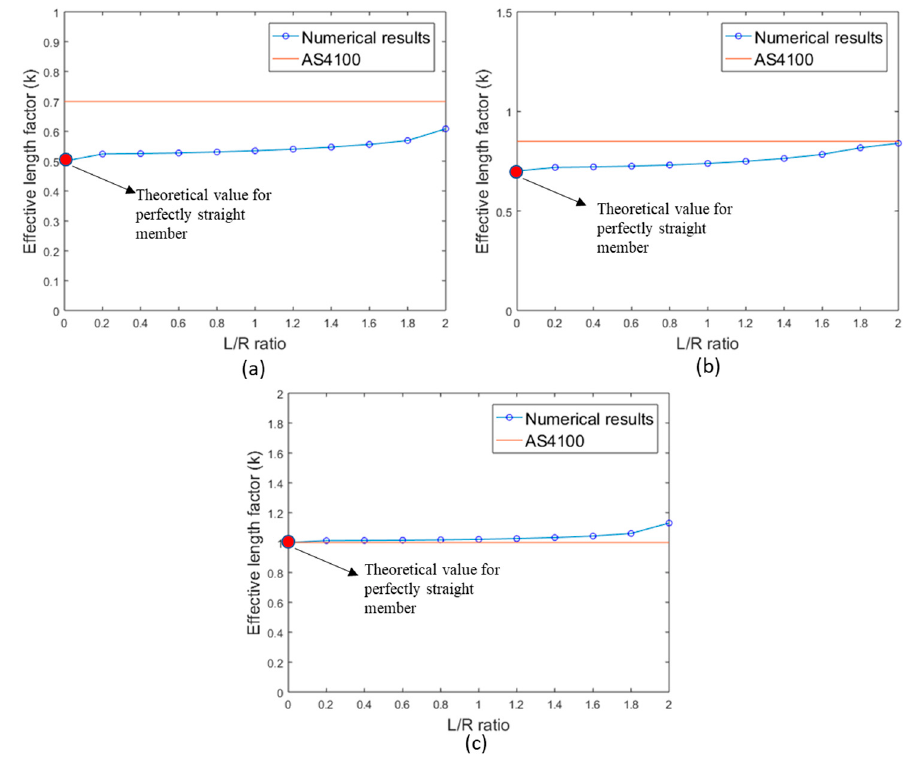
Figure 18. The effective length factor ( k e ) of curved columns under different L/R ratios: ( a ) braced member case 1; ( b ) braced member case 2; ( c ) braced member case 3.